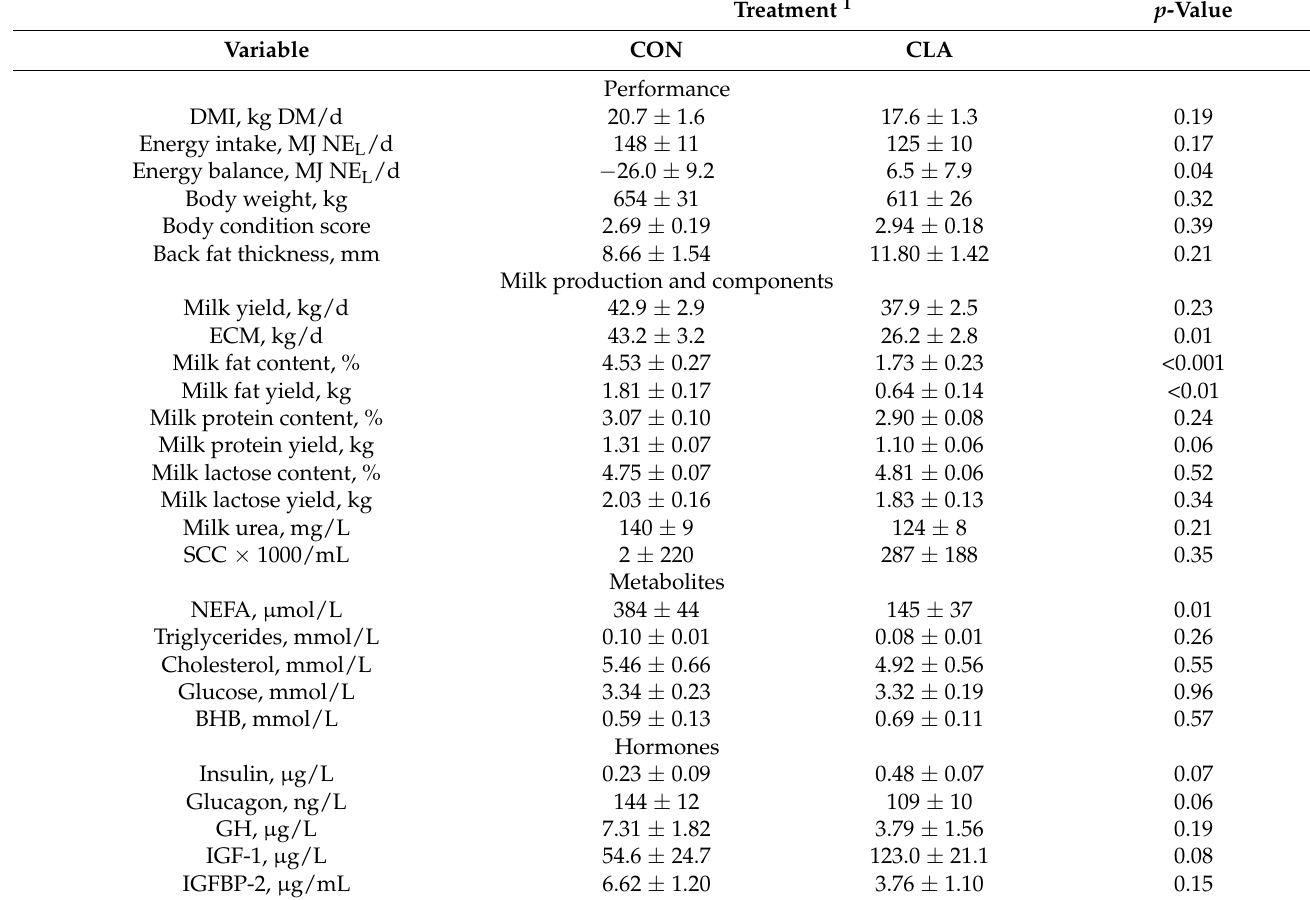
Table 1. Animal performance data, milk production and components, plasma metabolites, plasma hormones and plasma conjugated linoleic acid (CLA) content at wk 8 postpartum of cows abomasally supplemented either with: coconut oil [control, (CON); n = 5] or conjugated linoleic acid (CLA; n = 5) from d 63 antepartum until slaughter on d 63